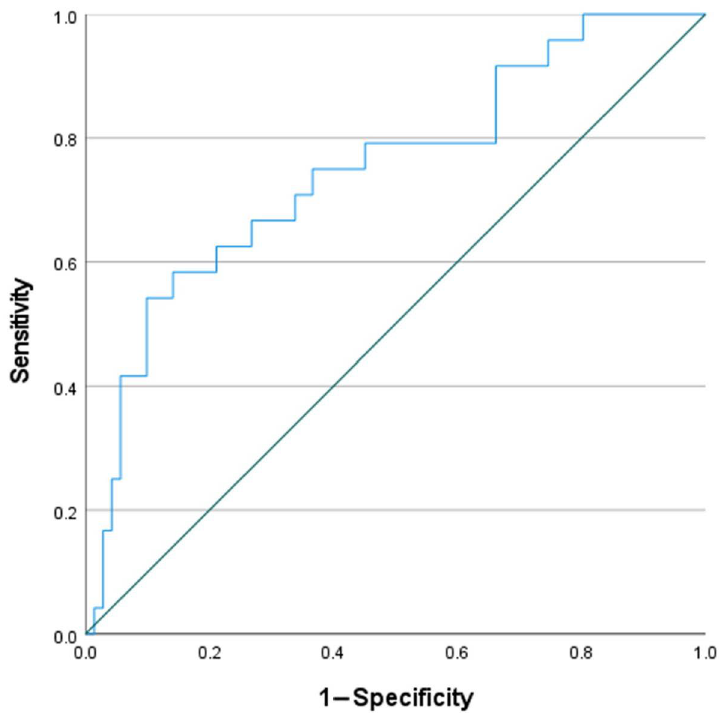
Figure 4. ROC curve showing sensitivity and specificity of CRP values at admission and occurrence of cerebral vasospasm ( p <